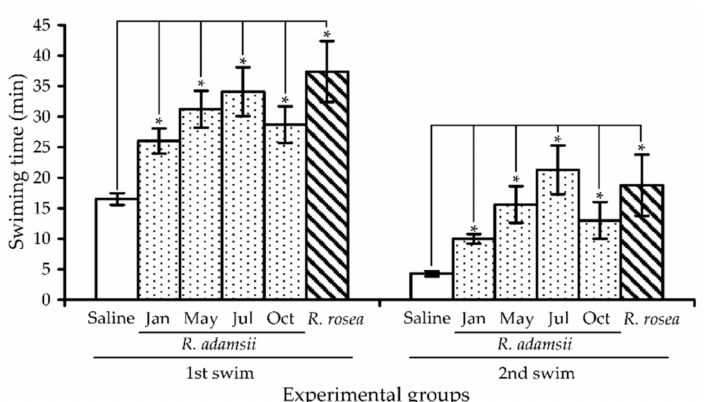
Figure 11. Effects of four different R. adamsii leaf extracts (January, May, July, and October samples) and R. rosea extract (50 mg/kg) on swimming time of mice in a two-step swimming to exhaustion test. * — p < 0.05 vs. saline